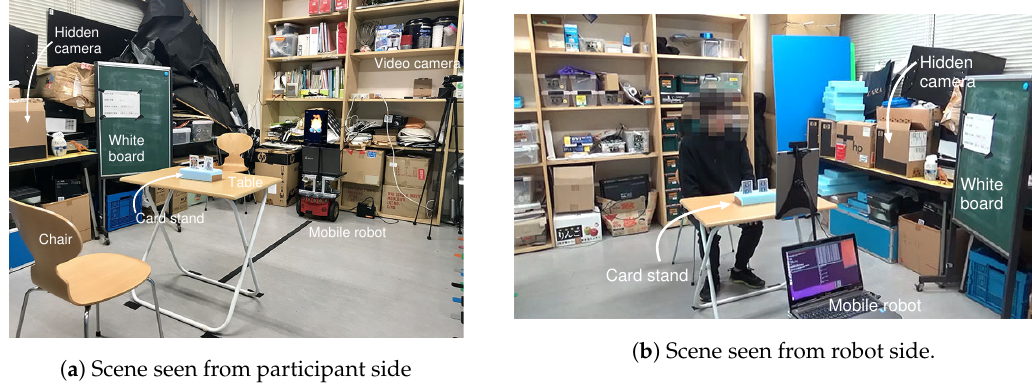
Figure 13. Scene example of evaluation experiment.